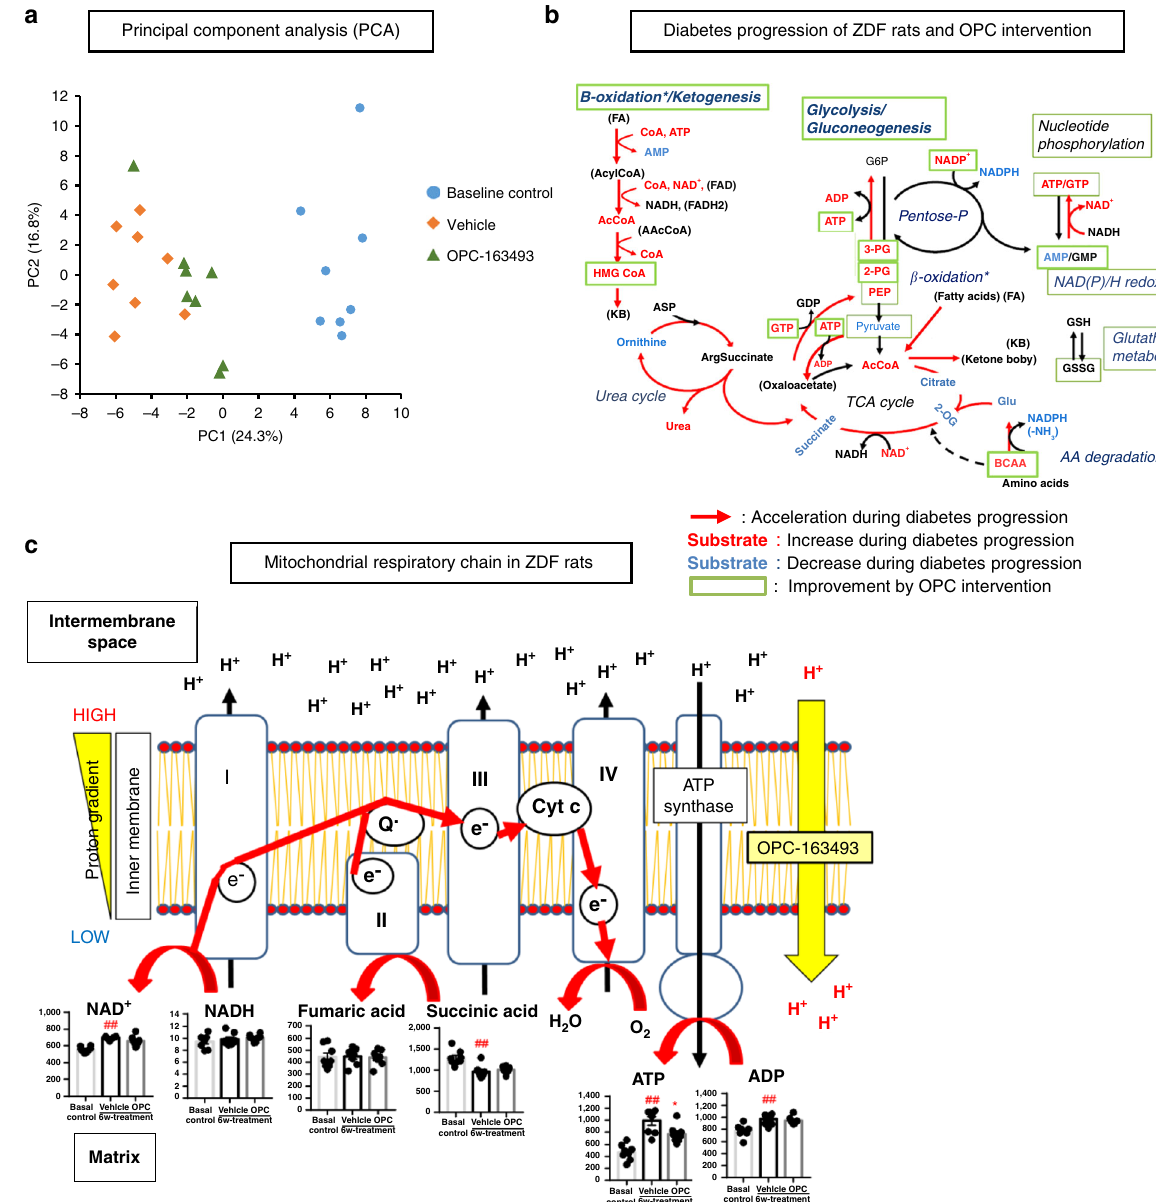
Fig. 7 Metabolomic analysis of long-term and in vivo effects of OPC-163493 in ZDF rats. At baseline, liver samples were taken from the baseline control group of 11-week-old ZDF rats and the other animals were started on oral administration (BID) of OPC-163493 (6 mg kg − 1 day − 1 ) or its vehicle solution. After 6-week dosing (at the age of 17 weeks), liver samples were taken from both animals, and the liver metabolites of all three groups were then analyzed and compared. a PCA of metabolomics data comparing liver metabolites between baseline control (blue circle), vehicle 6-week-treated (orange diamond), and OPC-163493 6-week-treated (green triangle) groups of ZDF rats ( n = 8). b Schema of diabetes progression and effects of OPC-intervention in the ZDF rats. Red arrows, substrates of red letters and blue letters represent accelerated pathways (imputed from the metabolite changes), signi fi cantly increased substrates, and decreased substrates, respectively, in the course of diabetes progression aged between 11 and 17 weeks in ZDF rats. Ameliorated pathways and substrates (signi fi cantly reversed to baseline) by OPC-intervention are enclosed in green boxes. AAcCoA Acetoacetyl CoA. c OXPHOS activation in the liver MRC along with diabetes progression of ZDF rats and uncoupling effect of OPC-163493. Data represent mean ± SE ( n = 8, ∗ P < 0.05, ∗∗ P < 0.01, vehicle group vs. OPC treatment group using an unpaired t test, # P < 0.05, ## P < 0.01, Baseline control group vs. vehicle group using an unpaired t test). All units of vertical lines in metabolite graphs are nmol g-tissue − 1 (except ratios of